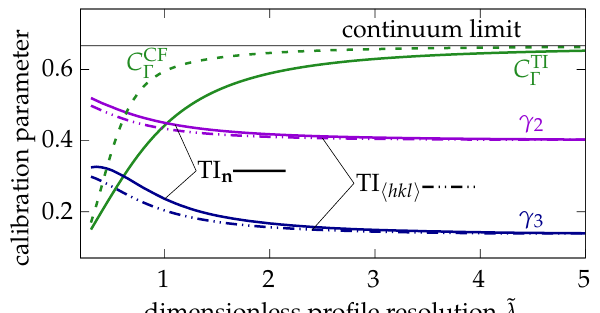
Figure 5. Different interface energy calibration parameters C Γ ( ˜ λ ) (solid and dashed green curves) and ponderation coefficients γ 2 ( ˜ λ ) (solid and dash-dotted violet curves), γ 3 ( ˜ λ ) (solid and dash-dotted blue curves) as functions of the profile resolution ˜ λ . γ 1 = 1 − γ 2 − γ 3